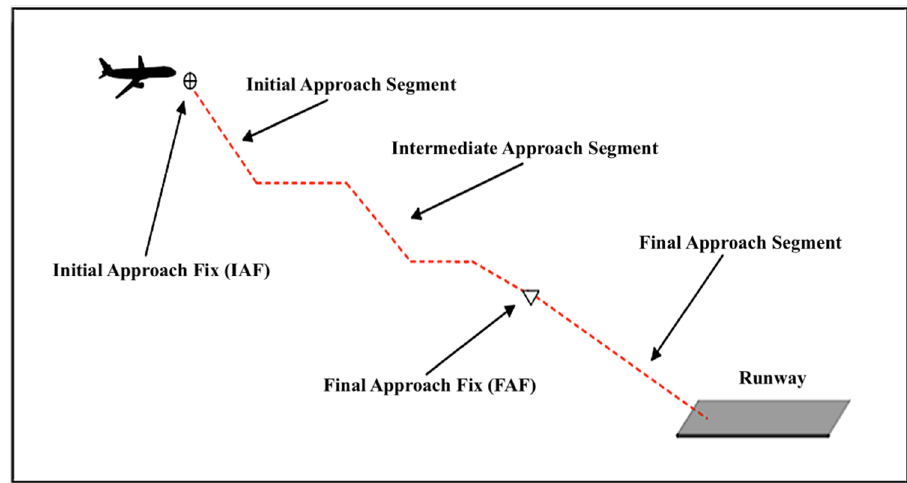
Figure 2. The vertical profile of SDA based on the IAP and approach segments.